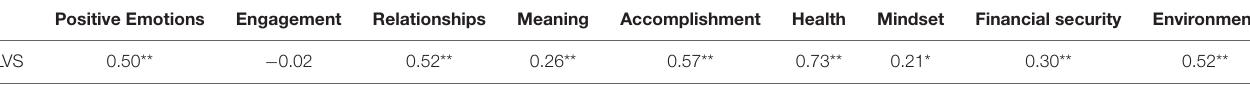
TABLE 10 | LVS correlations PERMA + 4 pathways. Positive Emotions Engagement Relationships Meaning Accomplishment Health Mindset Financial